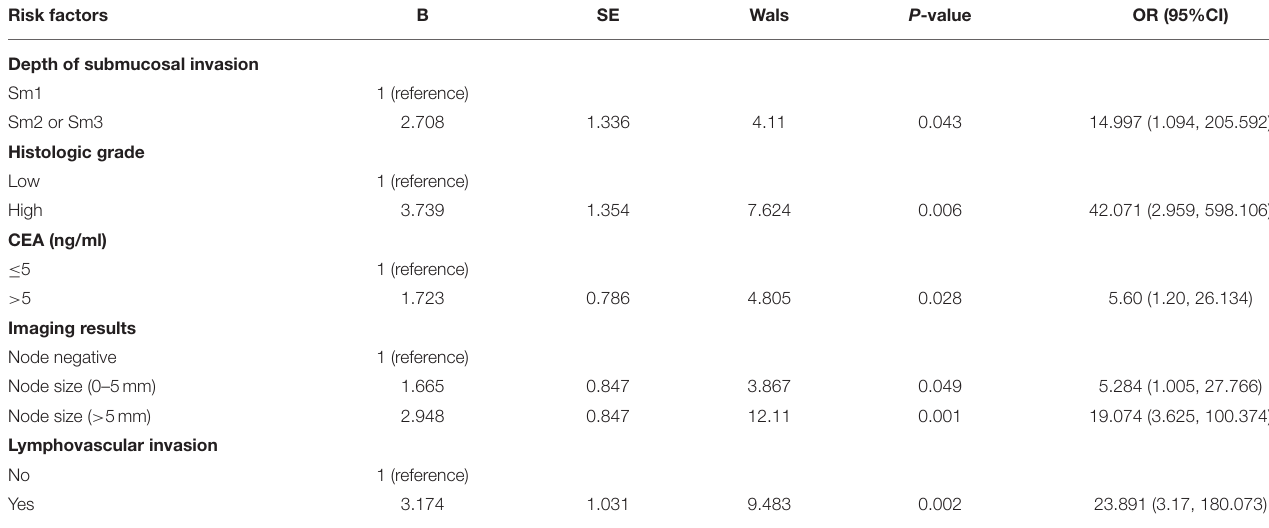
TABLE 2 | Multivariate analysis of risk factors for lymph node metastasis in T1 colorectal